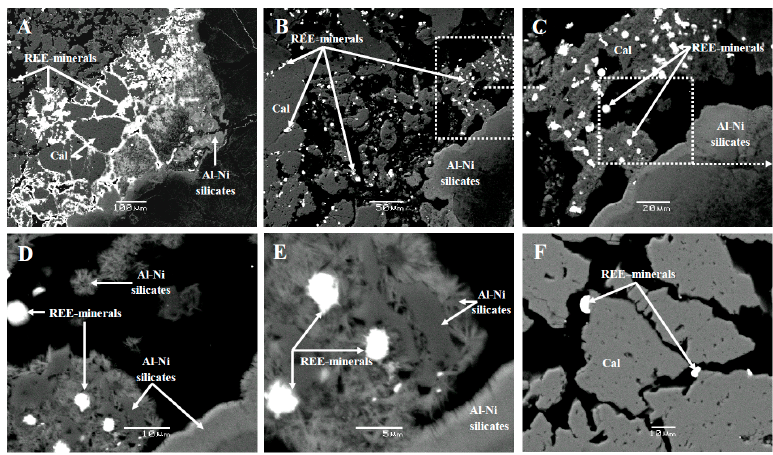
Figure 7. Representative back scattered images showing: Rare Earth Elements—minerals (white) associated with calcite ( A – C , F ) and Al–Ni–silicates ( B – E ) in the NB group of samples from the contact between the lowermost part of the bauxite laterite ore and the carbonate basement.